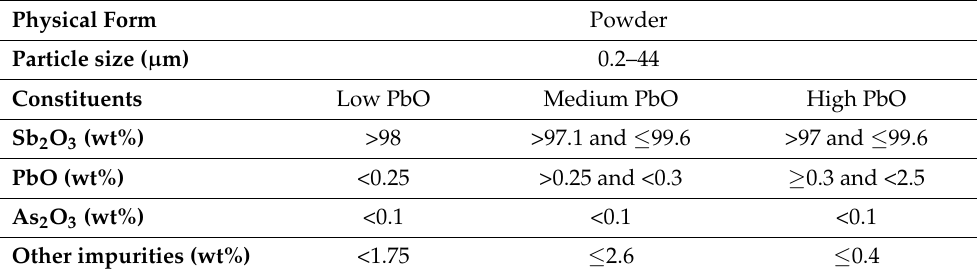
Table 2. Specifications of antimony trioxide products (adapted [8,9]).